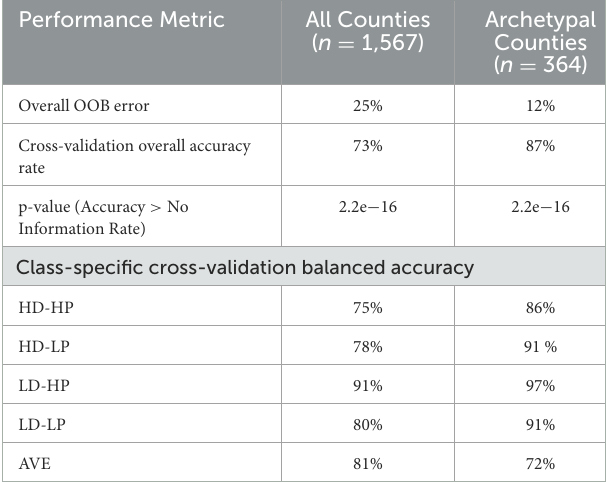
TABLE 2 Random forests analysis performance metrics. Performance